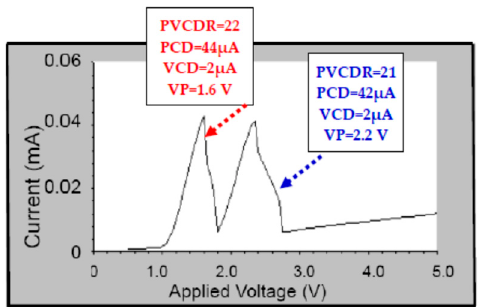
Figure 10. I-V curve of practical double PVCDR RTEC structure.